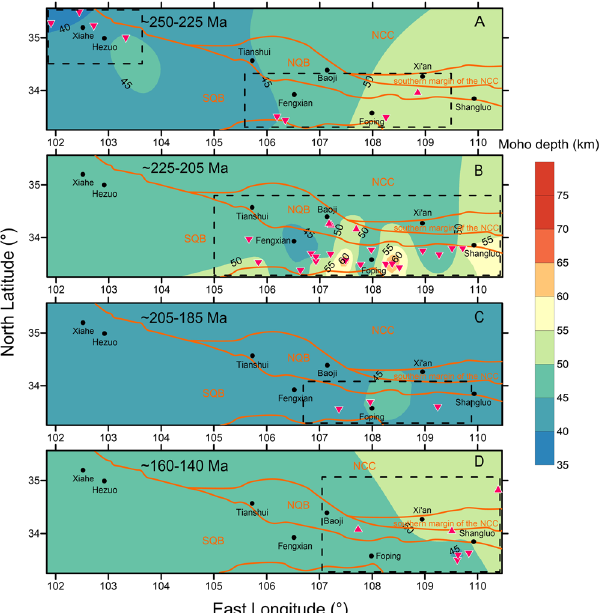
Figure 6. Contour plots of crustal thickness in the Qinling Orogenic Belt at different time periods. ( A ) ~250– 225 Ma; ( B ) ~225–205 Ma; ( C ) ~205–185 Ma; and ( D ) ~160–140 Ma. The dashed rectangles represent areas that have more reliable crustal thickness values constrained by calculated data points. Triangles represent data from the North Qinling Belt and inverted triangles represent data from the South Qinling Belt. The plotted data are listed in Supplementary Information. Abbreviation: NCC = North China Craton; NQB = North Qinling Belt; SQB = South Qinling